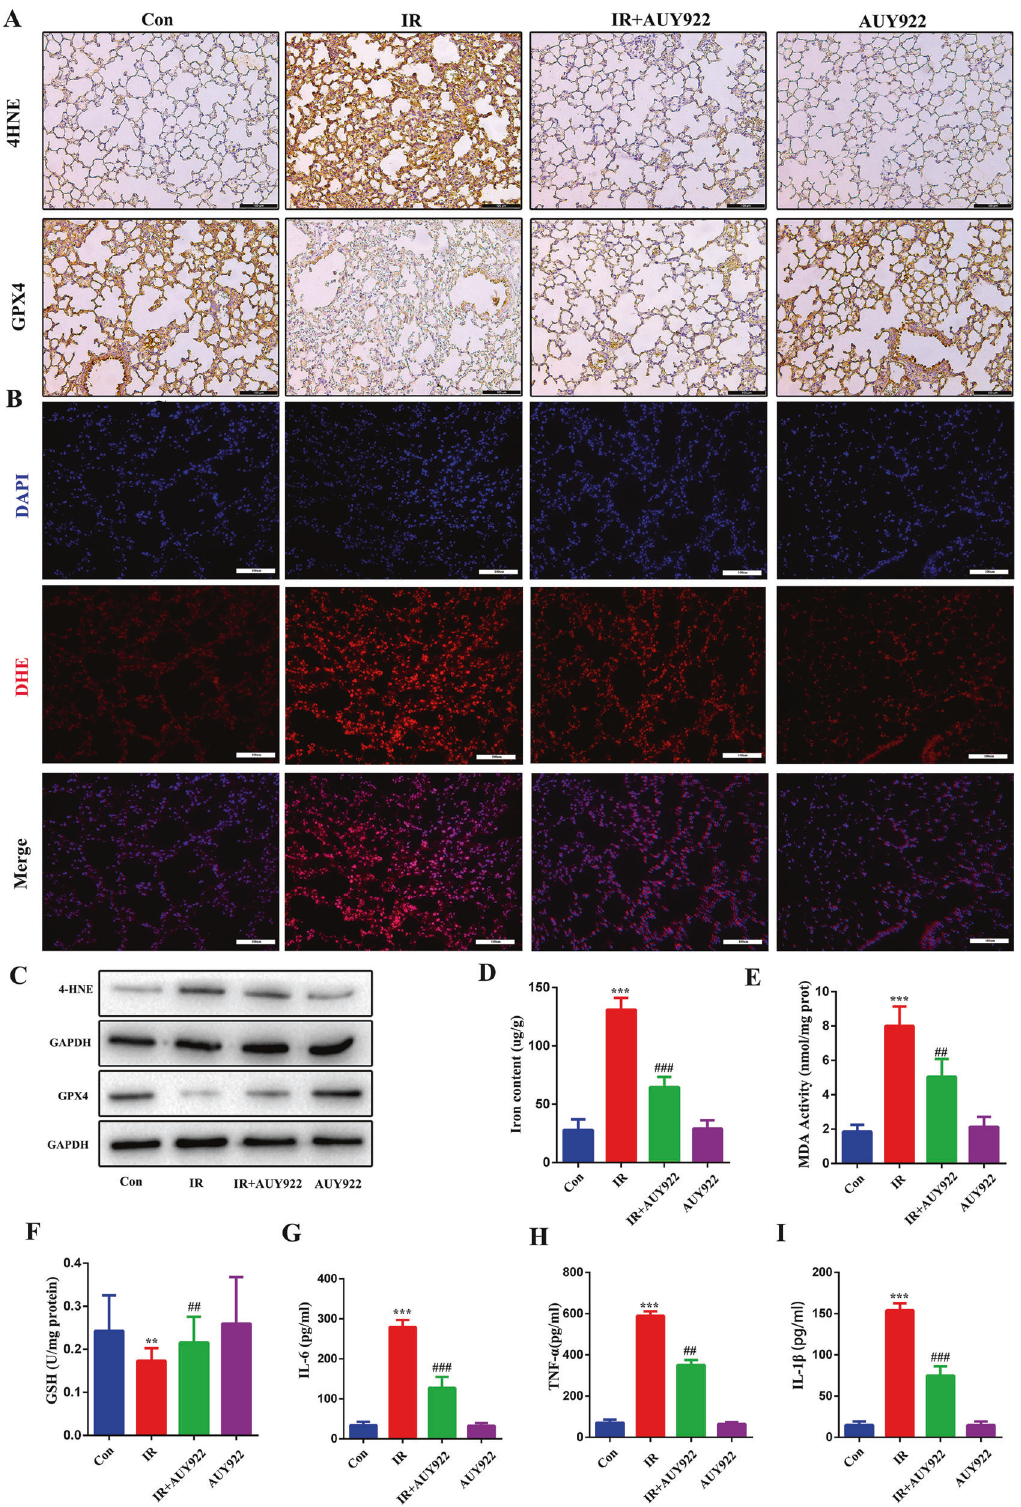
Fig. 5 NVP-AUY922 attenuates ferroptosis and in fl ammation induced by IR. A Representative IHC images of GPX4 and 4HNE in the lung sections. B Representative DHE fl uorescence images of the mouse lung tissues. C The levels of 4HNE and GPX4 in lung tissues. D – F Activities of iron content, MDA, and GSH in the mouse lung tissues. G – I Concentrations of IL-6 ( G ), TNF- α ( H ), and IL-1 β ( I ) in serum. #/ * P < 0.05, ##/ ** P < 0.01, ###/ *** P < 0.001, # vs. IR group; * vs. control group.